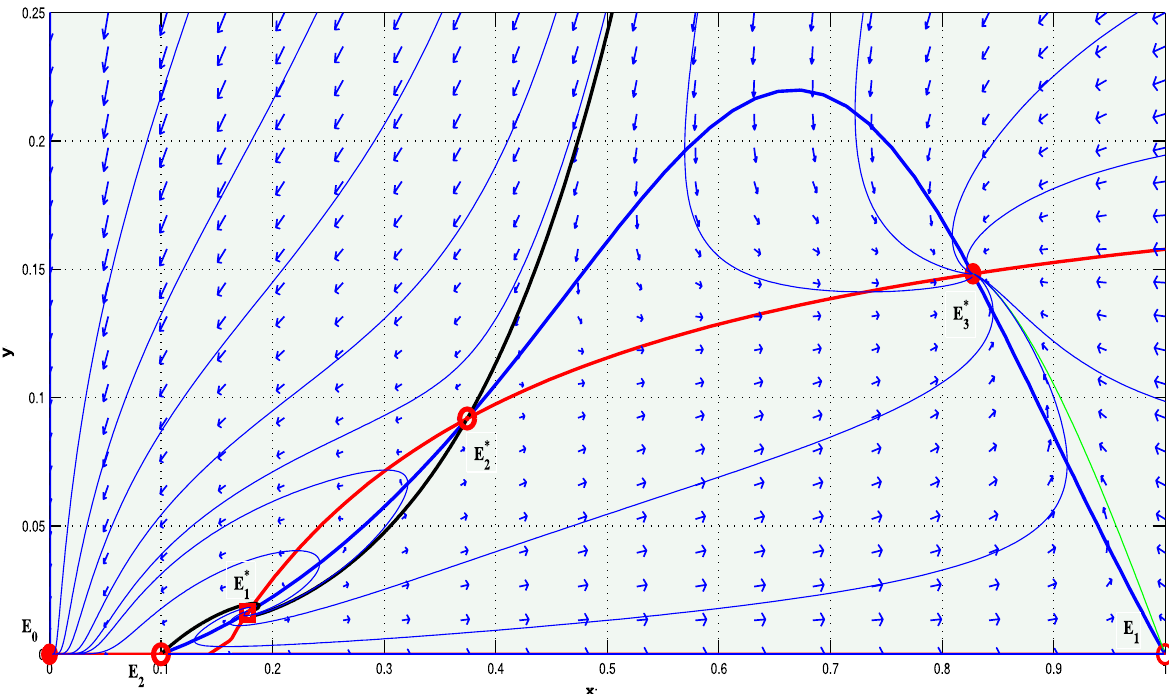
Figure 3. (Strong Allee effect): this figure represents phase portraits of (8) with three positive equilibria. The deep blue curve is the prey-nullcline and the curve presented in deep red is the predator-nullcline. The attractor equilibria are E 0 and E 3 , saddle equilibria are E 1 , E 2 and E ∗ 2 , unstable focus E ∗ 1 are highlighted with filled circles, open circles and square open box, respectively. The stable manifolds of the saddle equilibria ( E 2 and E ∗ 2 ), called the separatrix curves, are highlighted by solid black curves. E 0 and E 3 are separated by those two stable manifolds of saddle interior equilibrium point E 2 and E ∗ 2 , both of which are drawn with black curves. The parameter values used are given by l = 0.1, a = 7.8, b = 4.1, d = 0.7, β = 9.8